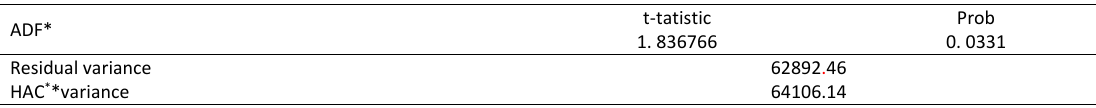
Table 2: The cointegration test